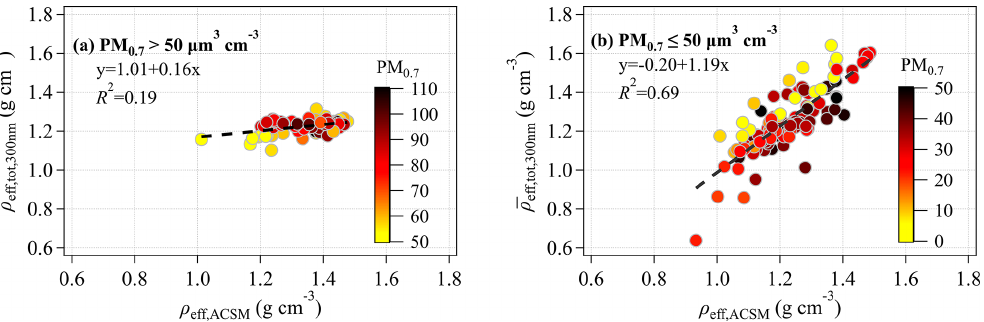
Figure 8. Comparison of the average effective density of particles at 300nm observed by DMA–CPMA–CPC ( ρ eff , tot , 300nm ) and ACSM- derived bulk effective density ( ρ eff , ACSM ) under (a) more polluted (corresponding to PM 0 . 7 > 50µm 3 cm − 3 ) and (b) less polluted (corre- sponding to PM 0 . 7 ≤ 50µm 3 cm − 3 ) conditions. Colored circles represent PM 0 . 7 volume